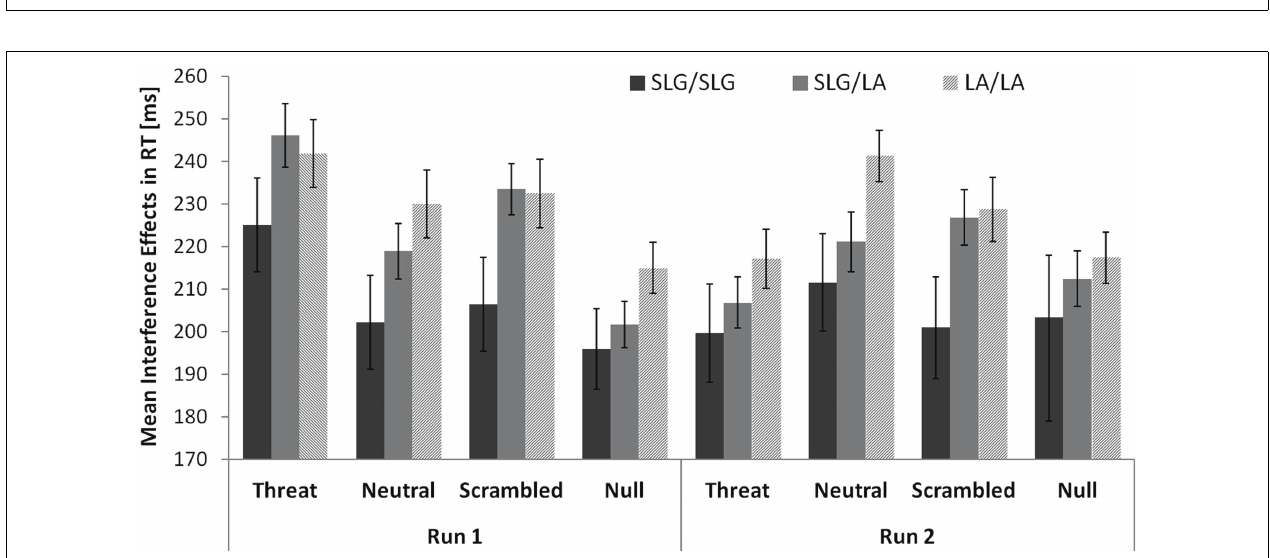
FIGURE 4 | No evidence that the 5-HTTLPR/rs25531 genotype modulates interference effects in RTs in healthy females. Error bars show standard errors of the